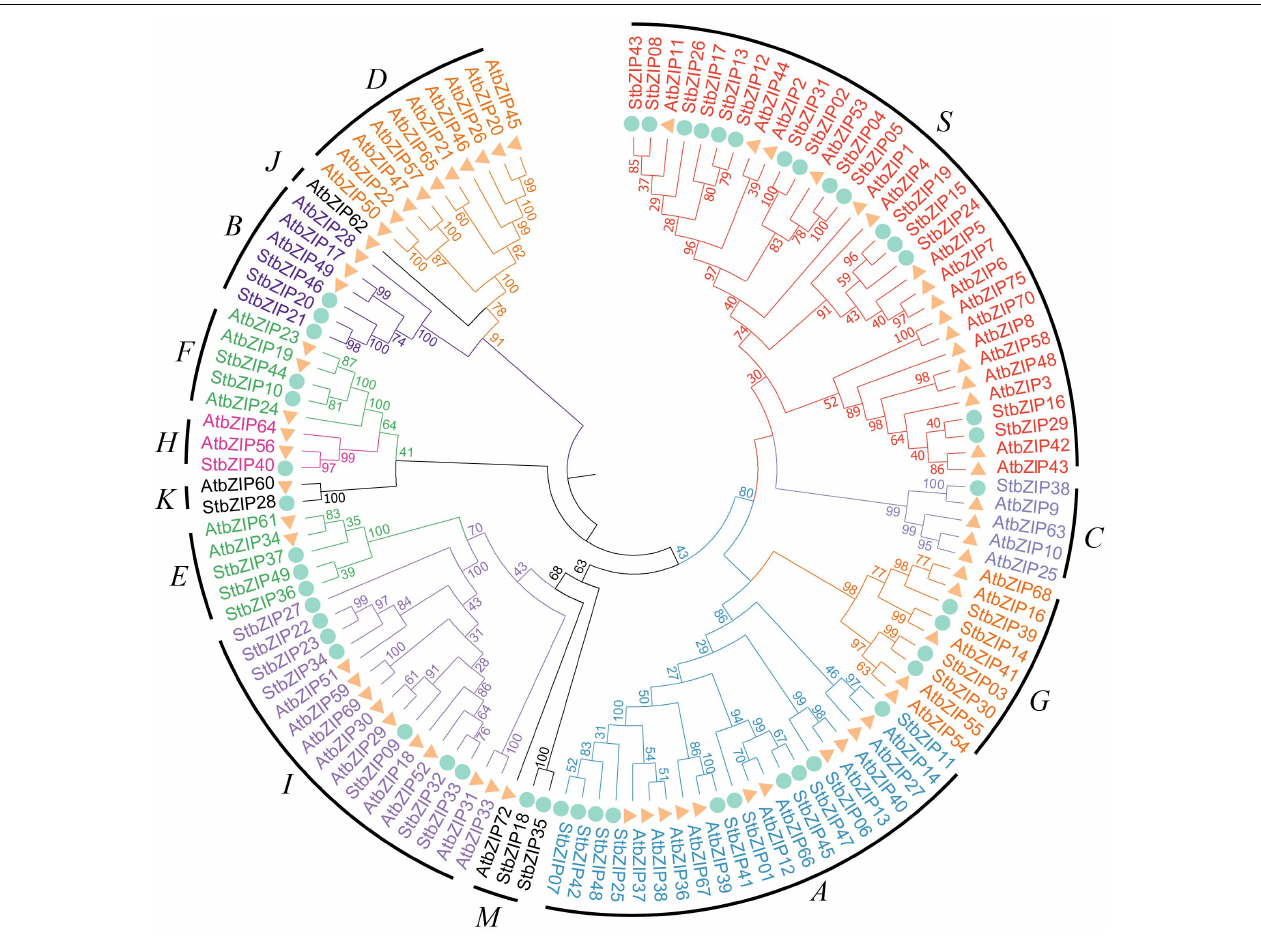
FIGURE 1 | Phylogenetic analysis of potato bZIP family members. The phylogenetic tree was generated from the alignment of potato and Arabidopsis bZIP proteins with 1,000 bootstrap replicates using the neighbor-joining (NJ) method. The potato bZIP members together with their Arabidopsis homologs were classified into 11